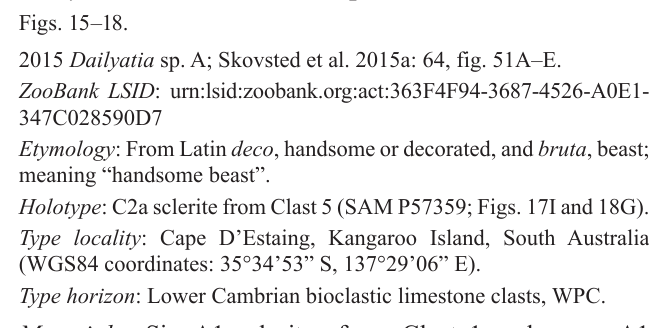
Holotype : C2a sclerite from Clast 5 (SAM P57359; Figs. 17I and 18G). Type locality : Cape D’Estaing, Kangaroo Island, South Australia